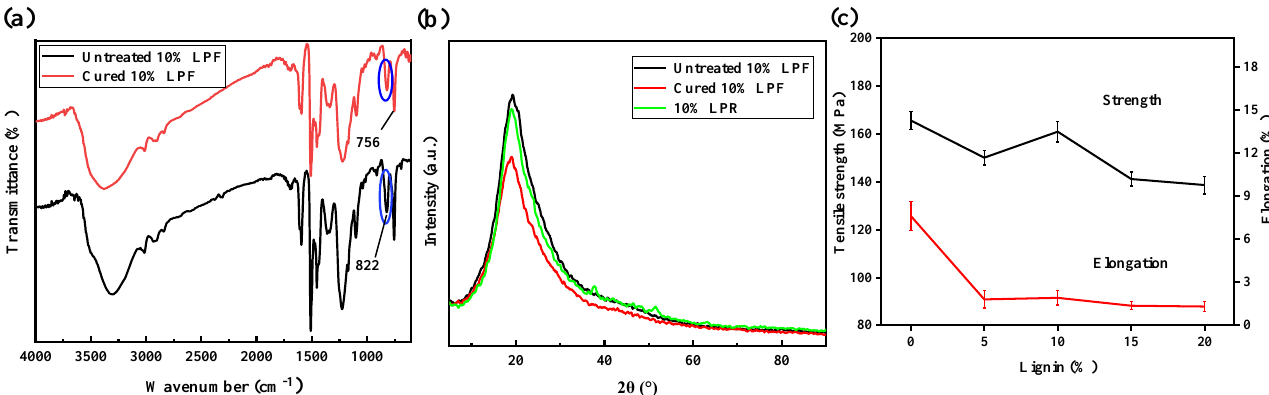
Figure 6. ( a ) FT-IR spectra of 10% LPF before and after curing; ( b ) XRD images of 10% LPR and 10% LPF before and after curing; ( c ) tensile strength and elongation of cured LPFs.